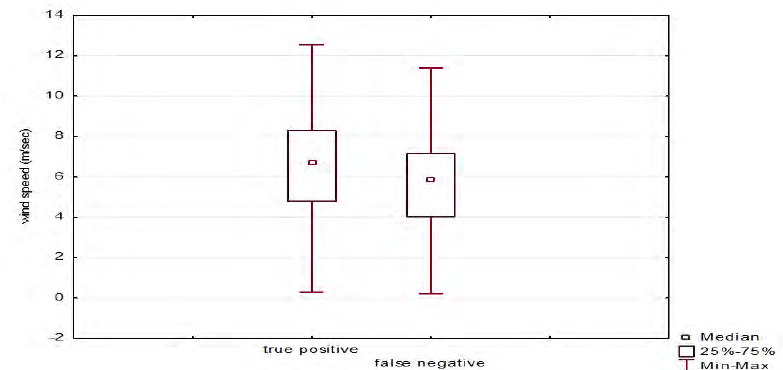
Fig. 9: Wind speed distribution during false positive and true